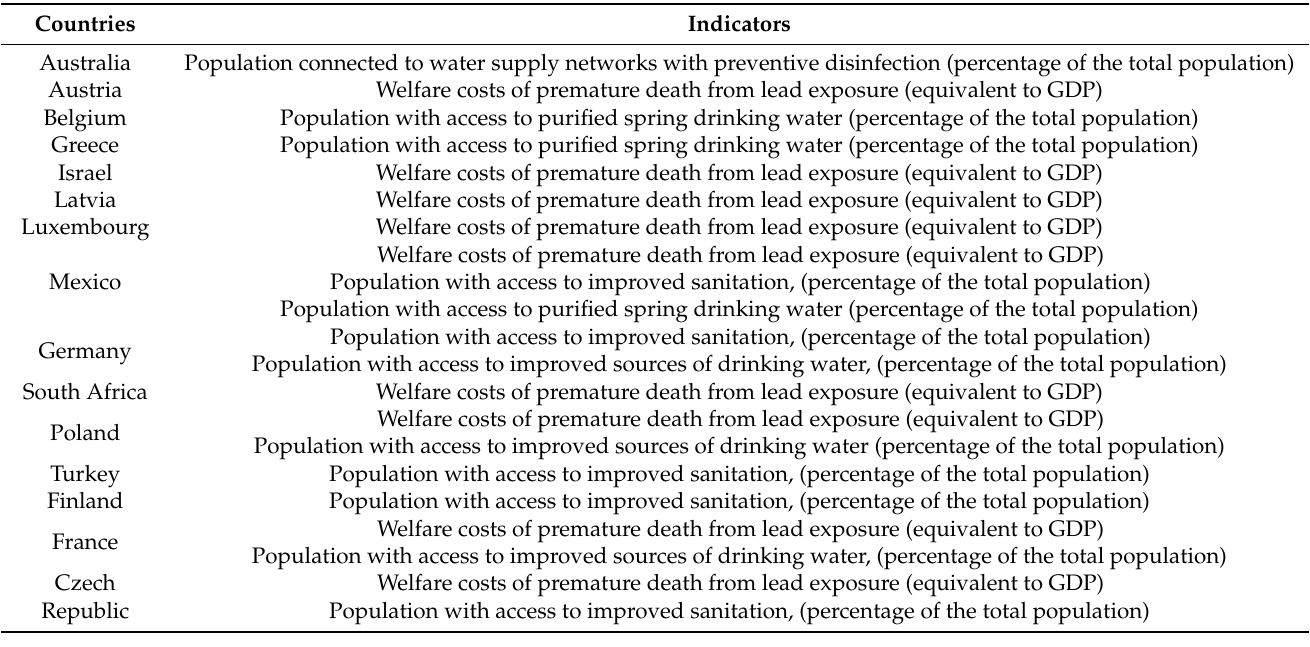
Table 2. Indicators that cause a decrease in the social component.